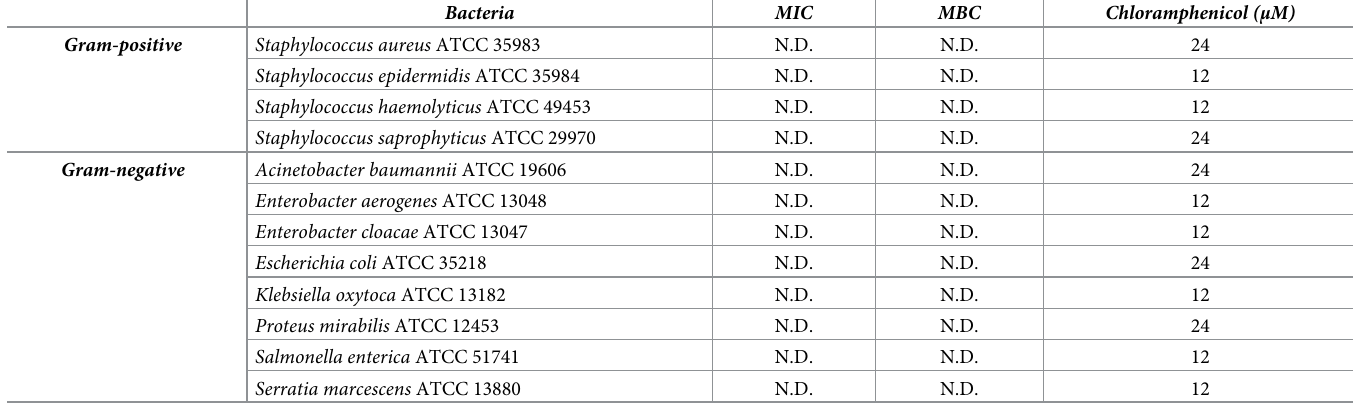
Table 3. Determination of the Minimum Inhibitory Concentration (MIC) and Minimum Bactericidal Concentration (MBC) of RPLO. The antibiotic chlorampheni- col was used as a positive control for the inhibition of bacterial growth. Bacteria MIC MBC Chloramphenicol (μM) Gram-positive Staphylococcus aureus ATCC 35983